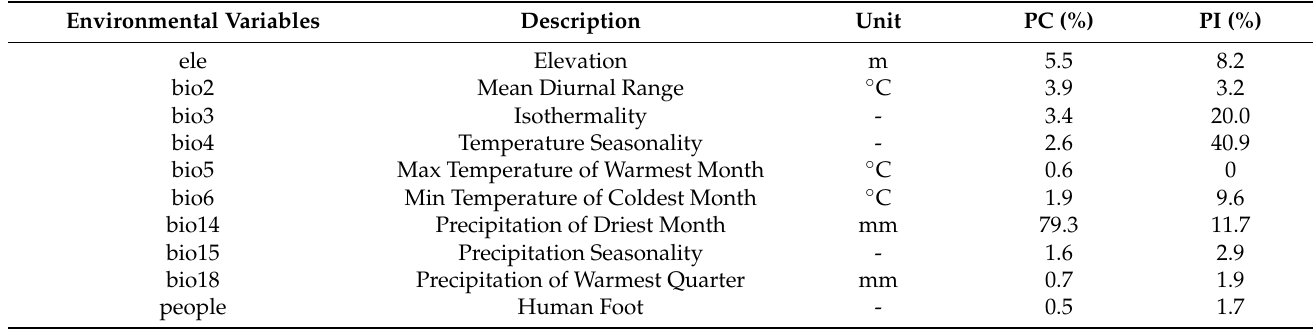
Table 1. Various parameters of the main environmental variables of Q. spinosa